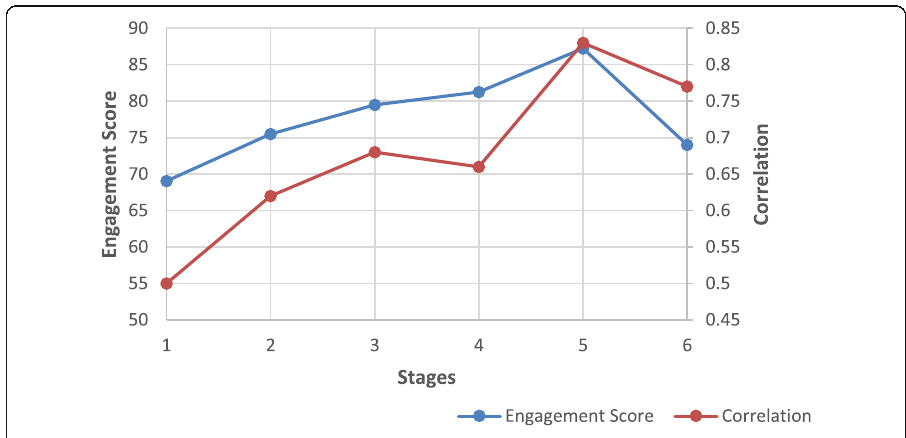
Fig. 4 Correlation of Student engagement and earned